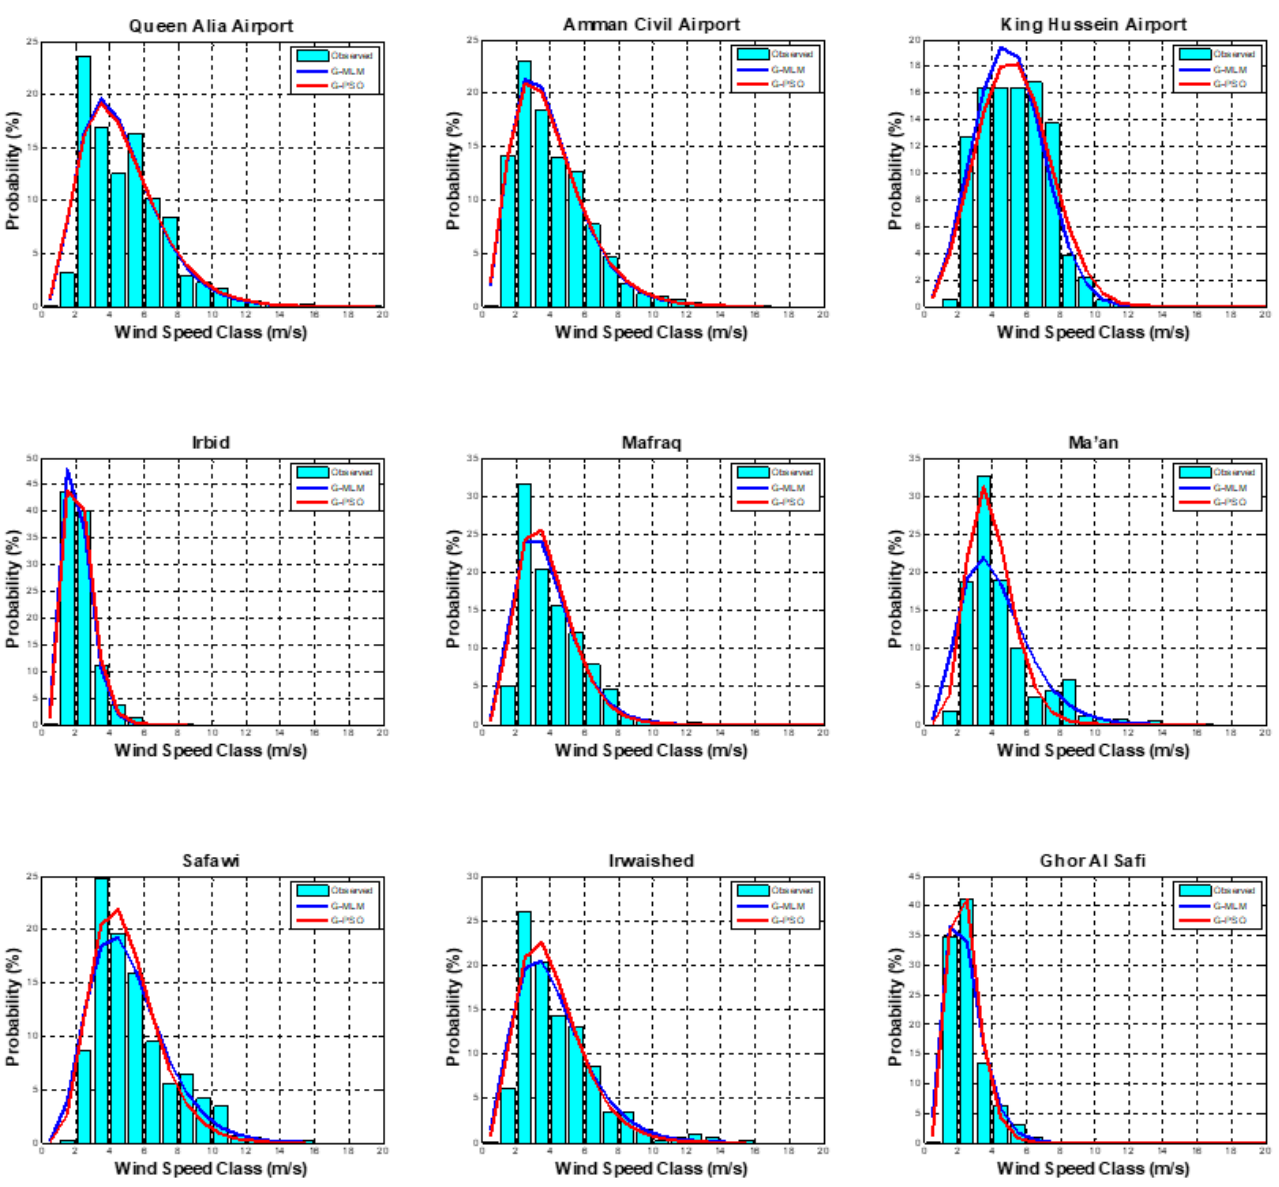
Figure 7. The PDF representation based on PSO and MLM estimation methods for all sites.